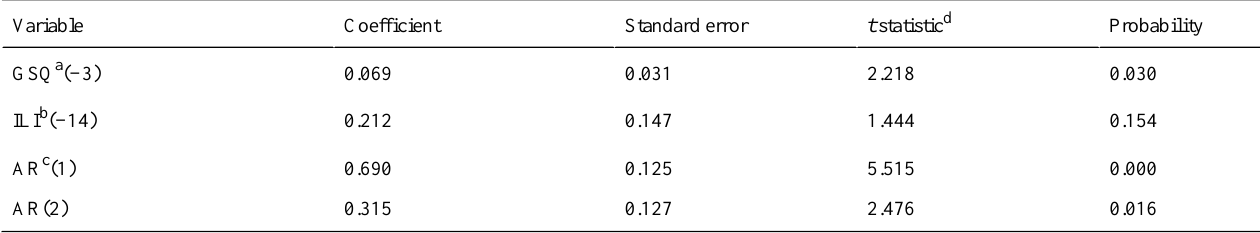
Table 5. Results of model (3).